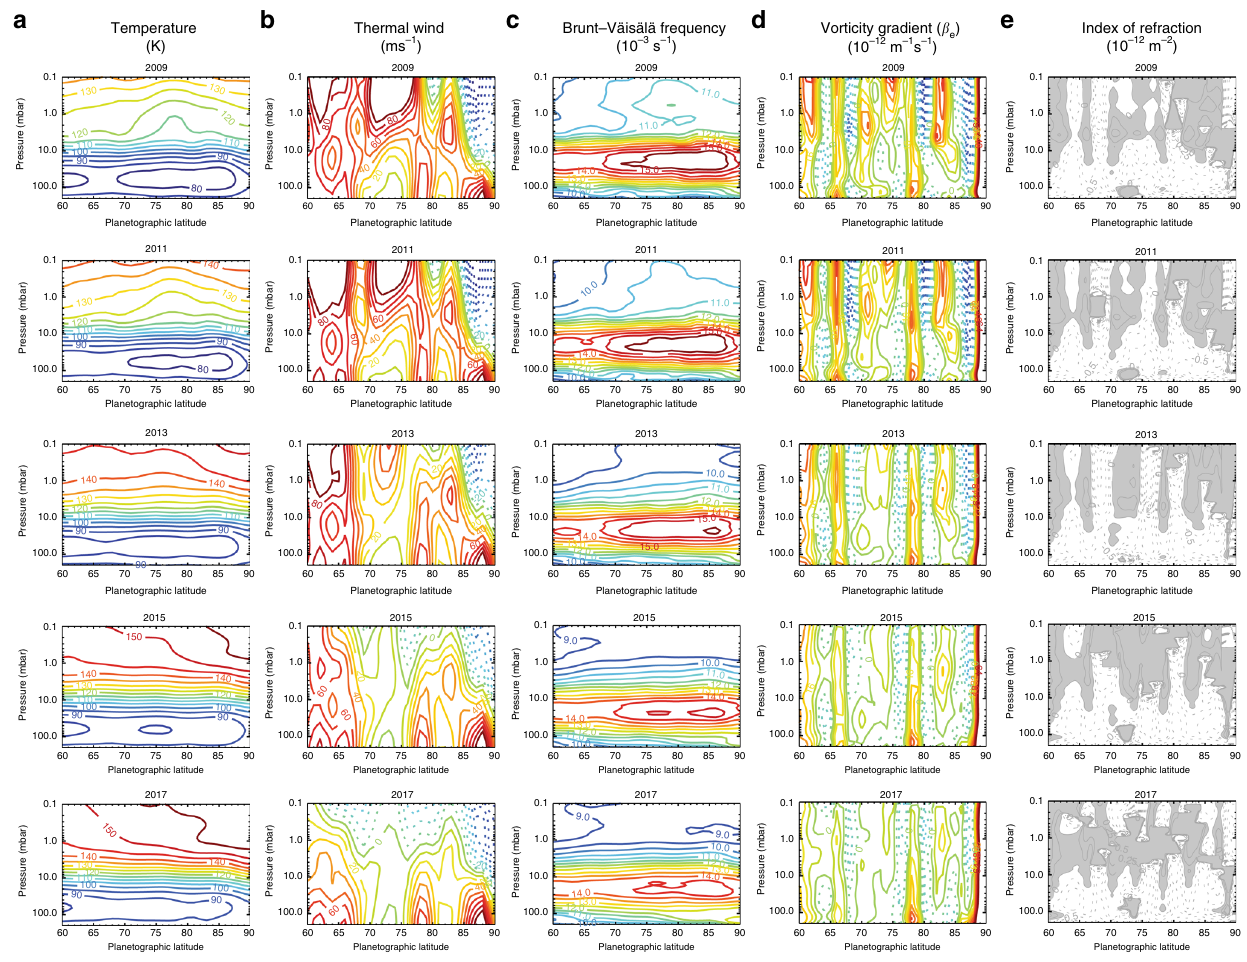
Fig. 10 Derived dynamical products based on the reconstructed north polar time series. Annual averages for 2009, 2011, 2013, 2015 and 2017 are shown in the fi ve rows. We show a the temperatures T , b zonal winds u , c Brunt – Väisälä buoyancy frequency N , d effective vorticity gradient β e and e the index of refraction v 2 . Negative values are shown as dotted contours, positive values as solid contours. In e , regions of real refractive index are shown in grey. In d , the scale for β e ranges from ± 80× 10 − 12 m − 1 s − 1 in steps of 8 ×10 − 12 m − 1 s − 1 . Contour lines in e for v 2 are drawn for ± 0.5 × 10 − 12 m − 2 , ±0.25 × 10 − 12 m − 2 and 0 m − 2 . Given the uncertainties in the thermal winds (see Methods), these panels should be considered as qualitative trends rather